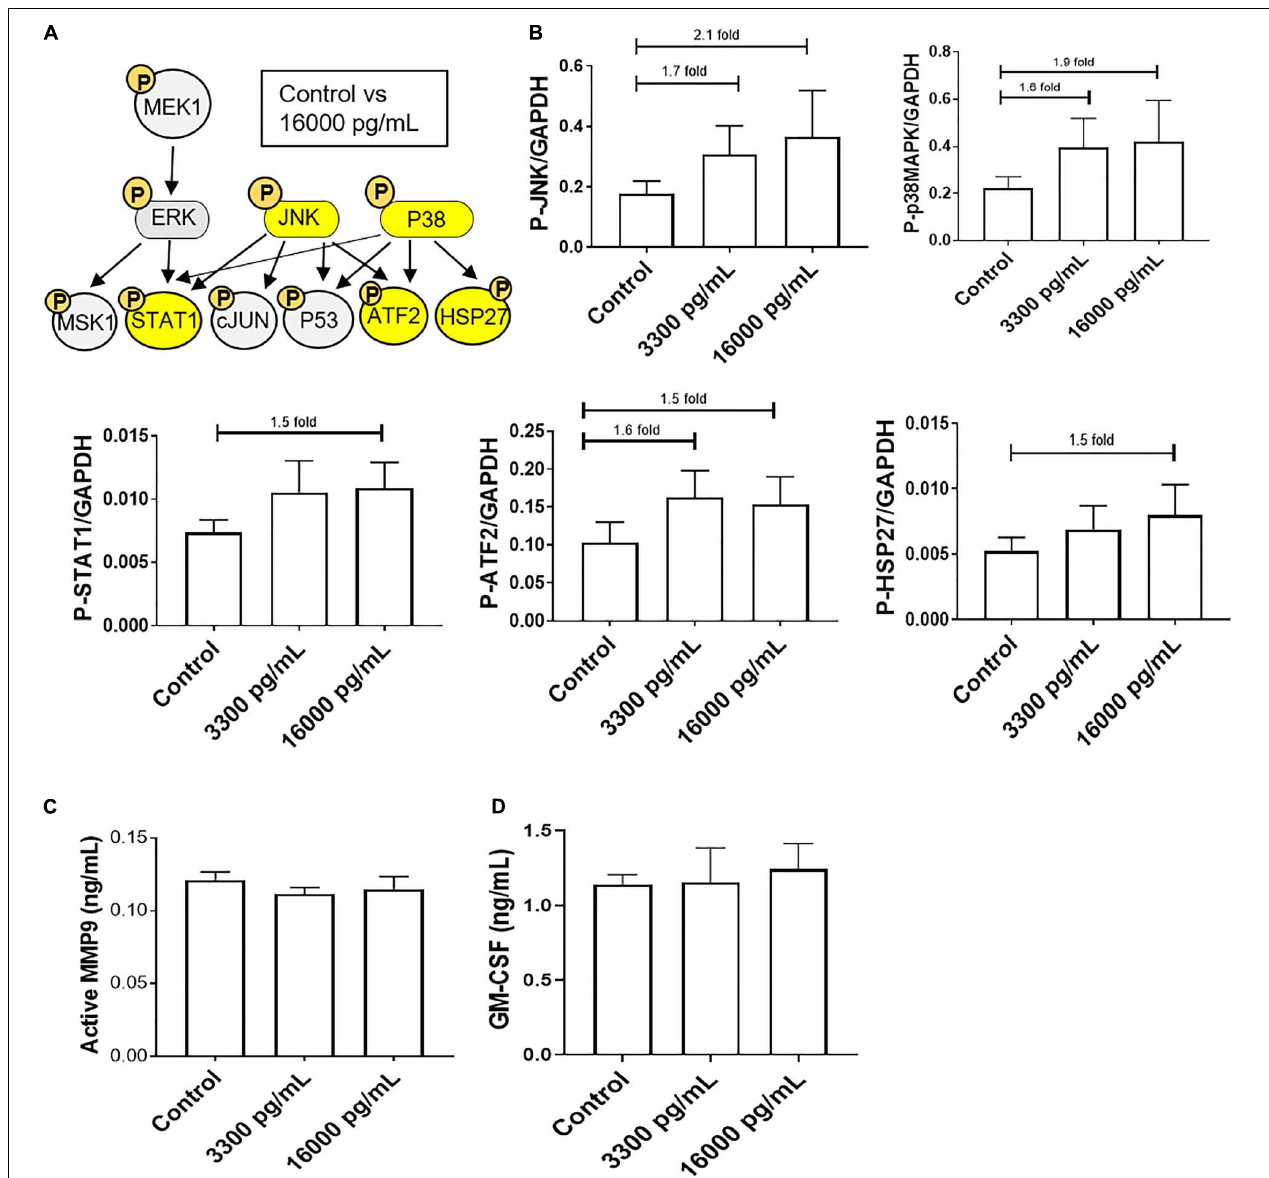
FIGURE 3 | IL-6 concentration reported in the amniotic fluid of infection associated pPROM activates JNK and p38MAPK leading to differential downstream kinase activation in AECs. (A) Schematic of various phosphorylated (P) kinases tested using a multiplex immunoassay. Highlighted (yellow) P-proteins were upregulated, though not significantly, after a high dose of IL-6 treatment (16,000 pg/mL) compared to control-treated AECs. (B) IL-6 treatment (16,000 pg/mL) of AECs showed increasing trends of upstream kinases activation, JNK (2.1-fold) and p38MAPK (1.9-fold), which contributed to the downstream activation of STAT1 (1.5-fold), ATF2 (1.5-fold), and HSP27 (1.5-fold) compared to control samples. N = 5; mean ± SEM medium florescent intensity. (C,D) A pathologic dose of IL-6 did not increase the inflammatory profile of AECs, as seen by no changes in MMP9 activation or GM-CSF production when compared to control or term labor IL-6 treatment (3,300 pg/mL). N = 5; mean ±